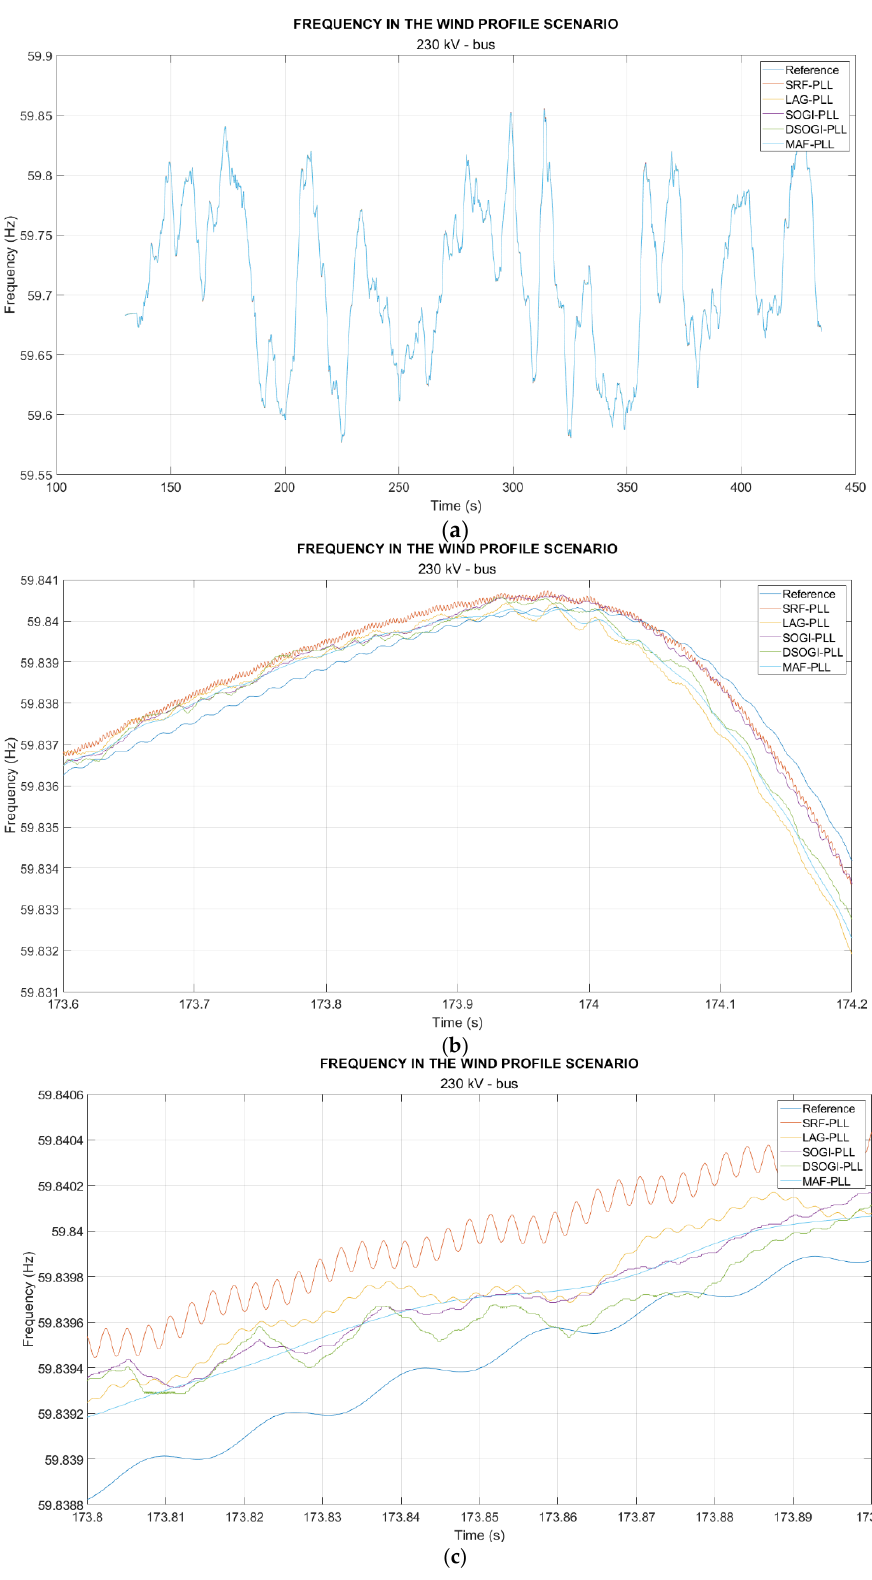
Figure 17. Frequency measurement with the PLLs located at the 230 kV WinGen bus in the variable wind speed scenario. The measurements are shown with different zoom levels: ( a ) from seconds 100 to 450, ( b ) from seconds 173.6 to 174.2, and ( c ) from seconds 173.8 to